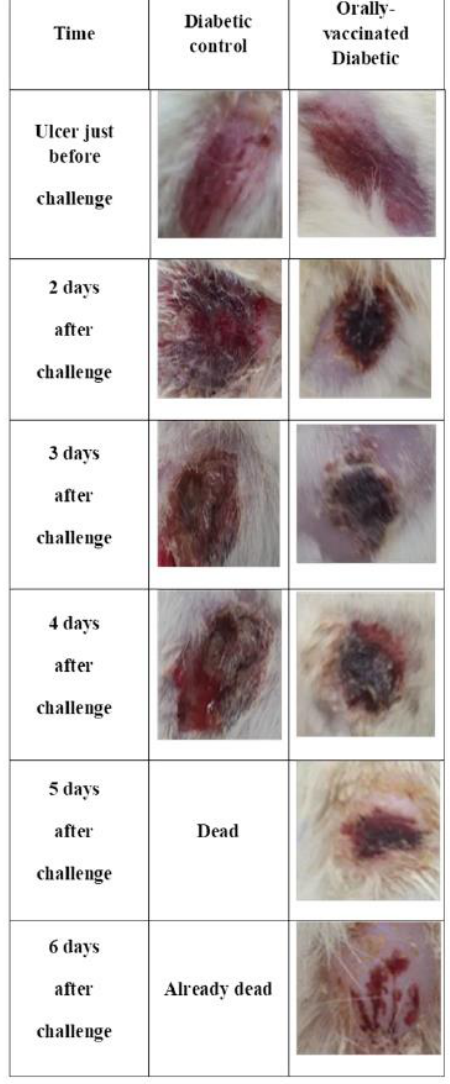
Figure 7. The rate of ulcer healing in various PA-infected animal groups. Artificial ulcers in vaccinated and unvaccinated diabetic rats were infected with PA and healing was observed for 6 days. All unvaccinated rats died by the fifth day post-challenge.